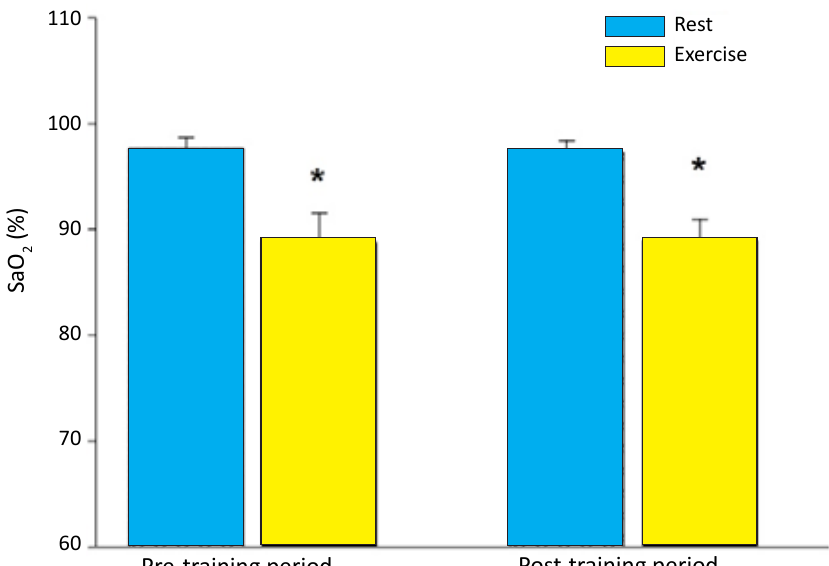
Figure 1 .* Significantly different from pre-training (baseline) values. SaO incremental treadmill test before (pre) and after (post) the 6-week training